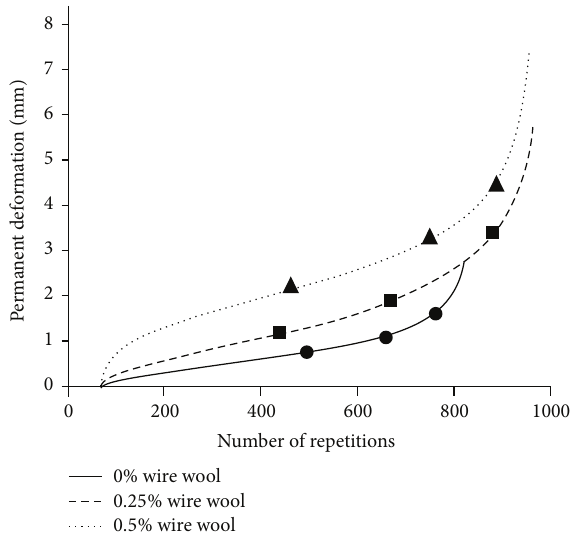
Figure 5: Permanent deformation behavior results for different HMA